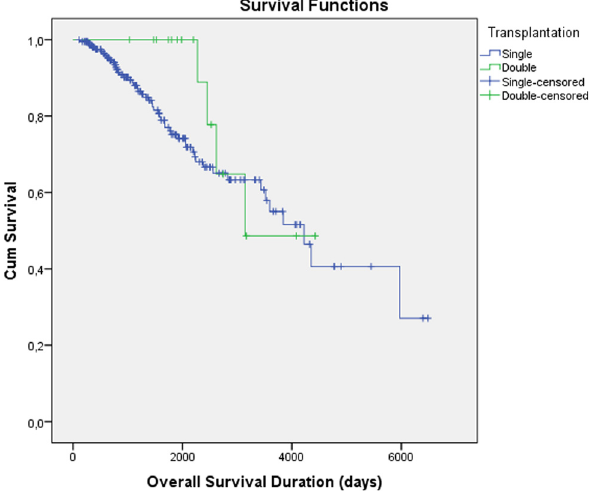
Figure 1: There is no statistically signi fi cant overall survival duration di ff erence between the single and double transplanted groups ( 4,011 ± 266 vs 3,526 ± 326 days, respectively, p : 0.33 )